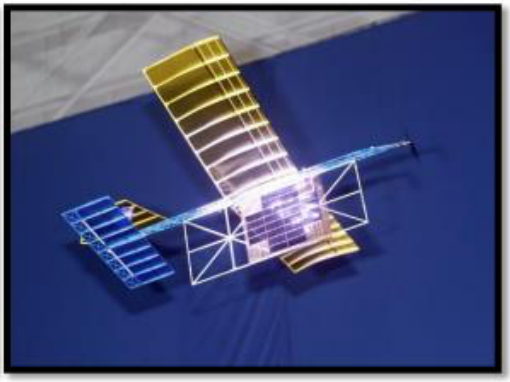
Figure 11. NASA uses LWPT technology to power for model UAVs.